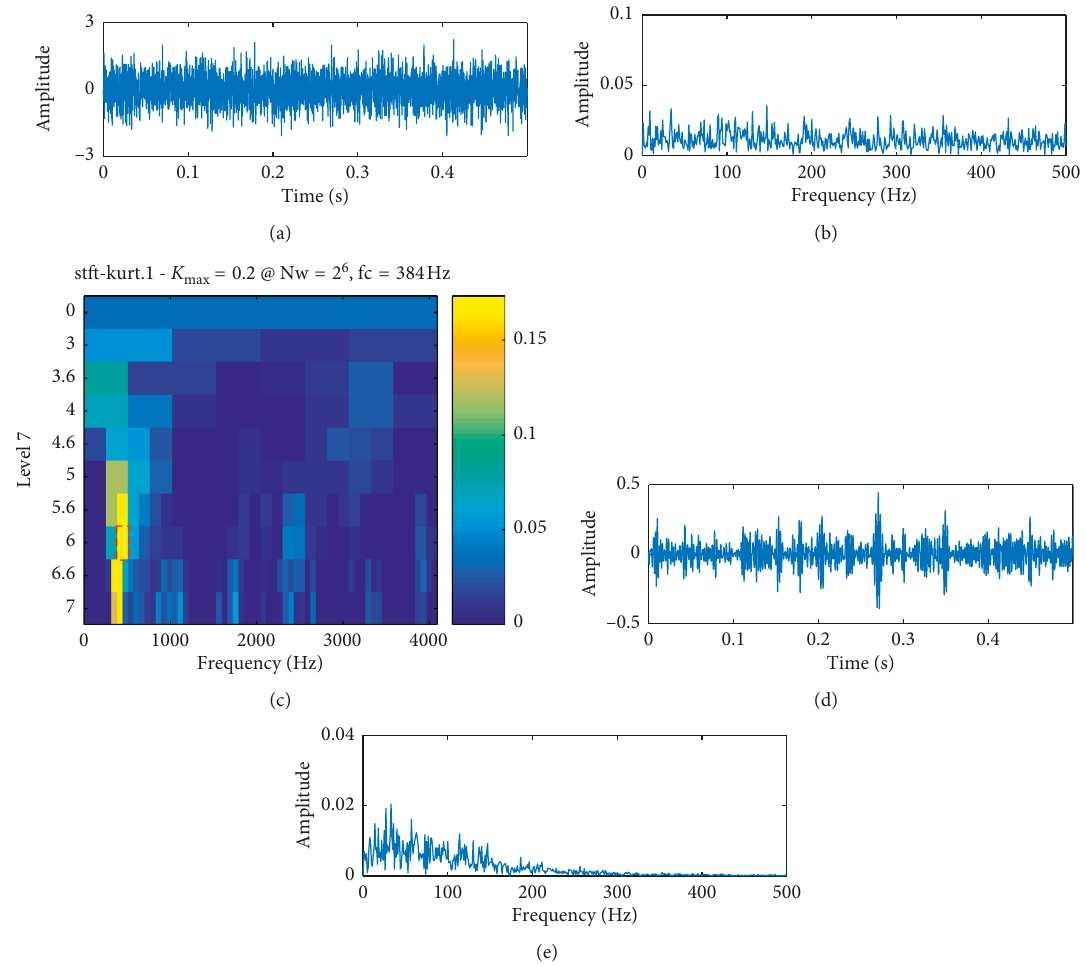
Figure 7: Diagnosis results of the simulation signal by EEMD-FSK: (a) TW of the reconstruction signal obtained by EEMD; (b) ES of (a); (c) kurtogram; (d) TW of the filtered signal obtained by FSK; (e) ES of